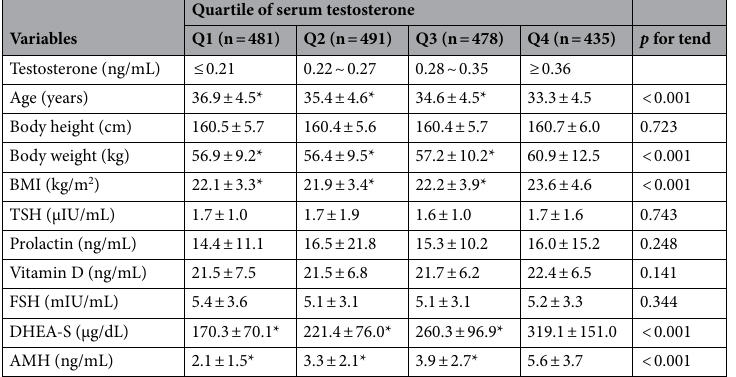
Table 2. Clinical characteristics according to serum testosterone quartile categories. Data are presented as the mean ± standard deviation. p values for trends were generated by linear regression analysis. *Statistically significantly different from the highest quartile category (Q4) using Bonferroni’s method in an analysis of variance (ANOVA) test. BMI body mass index, TSH thyroid-stimulating hormone, Vitamin D 25-OH-vitamin